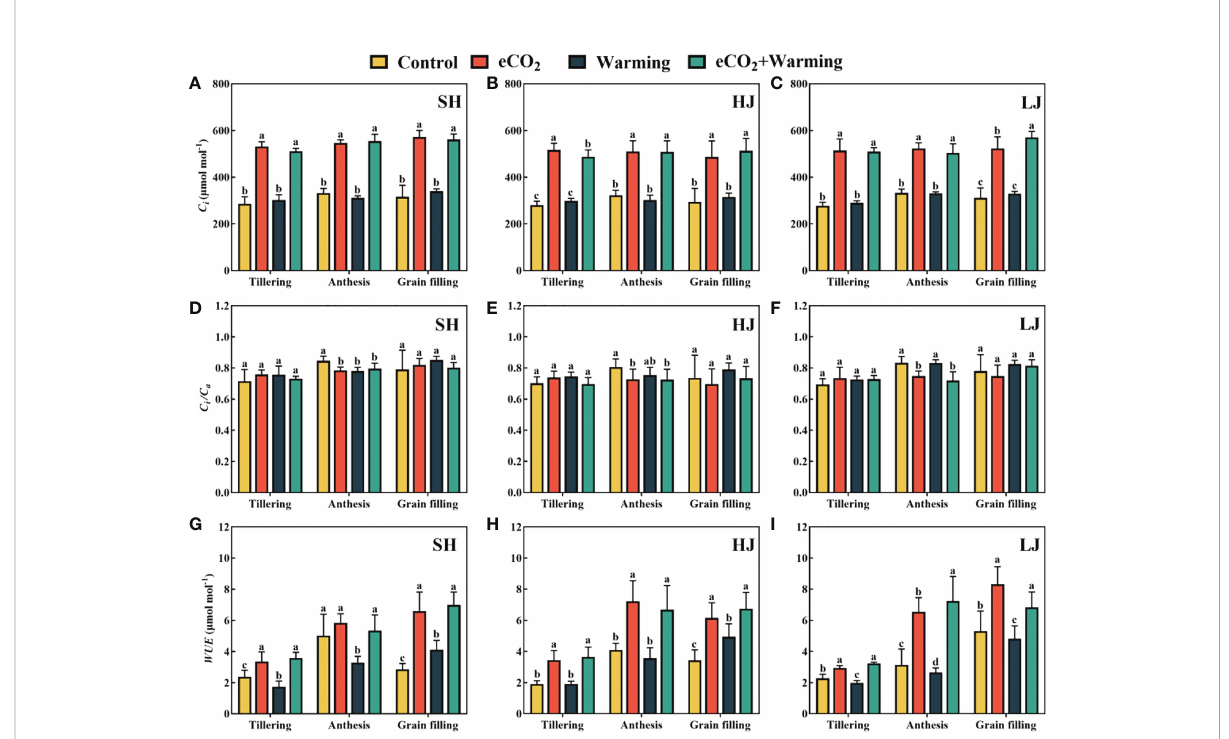
FIGURE 3 The value of C i (A-C) , C i / C a (D-F) and WUE (G-I) of three rice cultivars grown under control, ambient conditions; e[CO 2 ], elevated CO 2 concentration; warming, elevated air temperature; e[CO 2 ] plus warming, the combination of elevated air temperature and [CO 2 ]). SH, HJ and LJ represent rice cultivars Shishoubaimao, Hejiang 19, and Longjing 31, respectively. Values are the means ± SEs (n = 6). Different letters indicate signi fi cant differences between treatments at P < 0.05 level. C i , intercellular [CO 2 ]; C i / C a , the ratio of intercellular [CO 2 ] to ambient air [CO 2 ]; WUE , water use ef fi